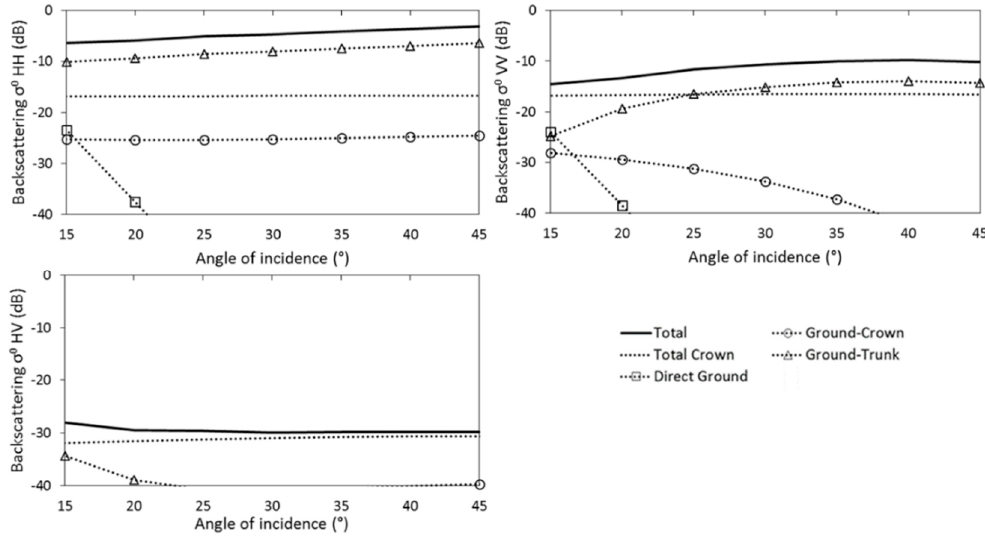
Figure 5. Total co-and cross-polarised canopy backscatter components vs. scattering angle from 830 leaves and 4.1 branch density Birch for S-band.